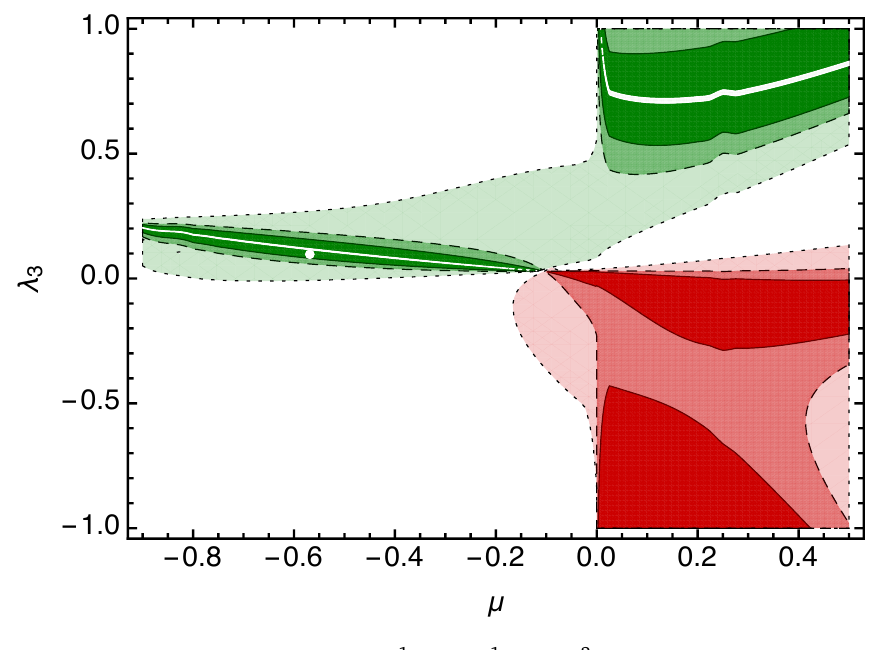
( (cid:34) < 1 ; (cid:34) < 3 ) are marked in dark (light, 5 3 4 = 1 and G → 0. The green s < 0 ( ∆ β > 0). The two green regions are centred G G independent, as are the fixed-point values of µ and λ s